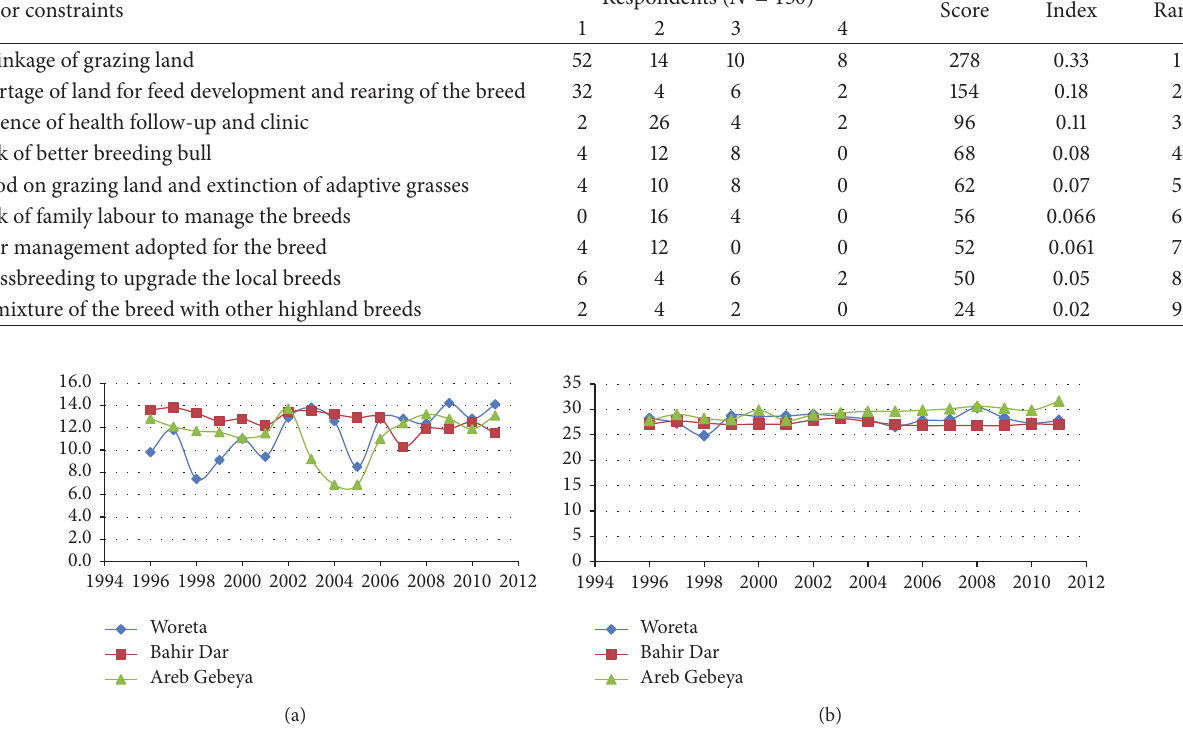
coupled with absence of health clinic (particularly at Fogera district) that were the major